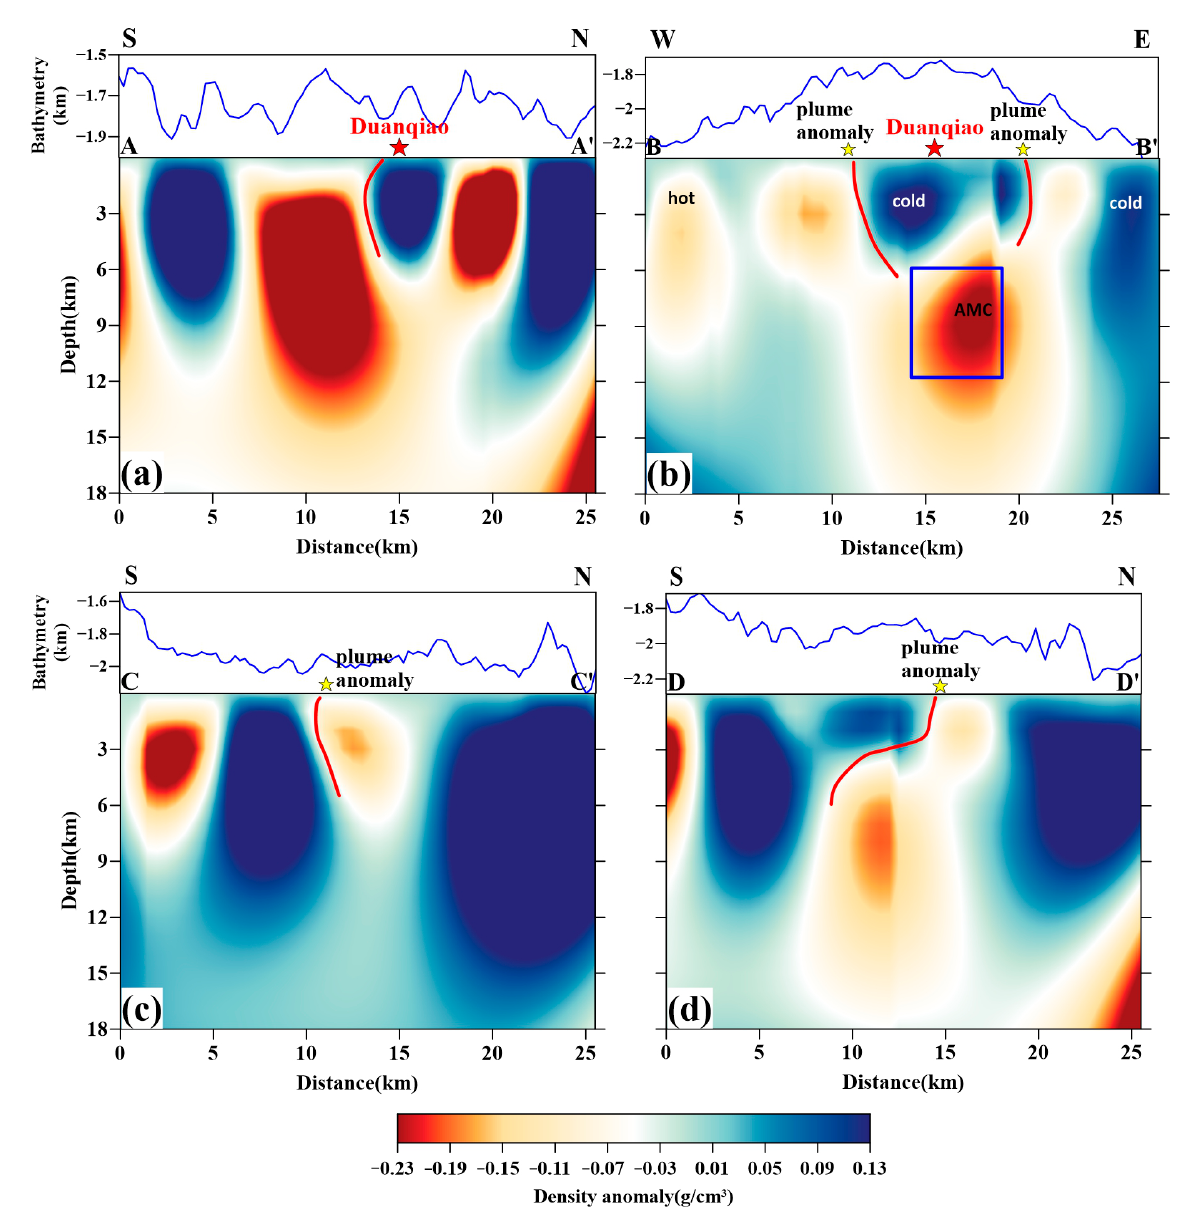
Figure 9. Vertical density anomaly profiles of ( a ) AA ′ , ( b ) BB ′ , ( c ) CC ′ , and ( d ) DD ′ across or along segment 27’s axis; locations are shown in Figure 8d. Bathymetry variations are shown at the top of these density anomaly profiles. The red star represents the Duanqiao hydrothermal field. Yellow stars indicate plume anomalies (see Figure 1). In these four profiles, the boundaries between low- and high-density anomalies are marked with red curves and regarded as possible fault structures.